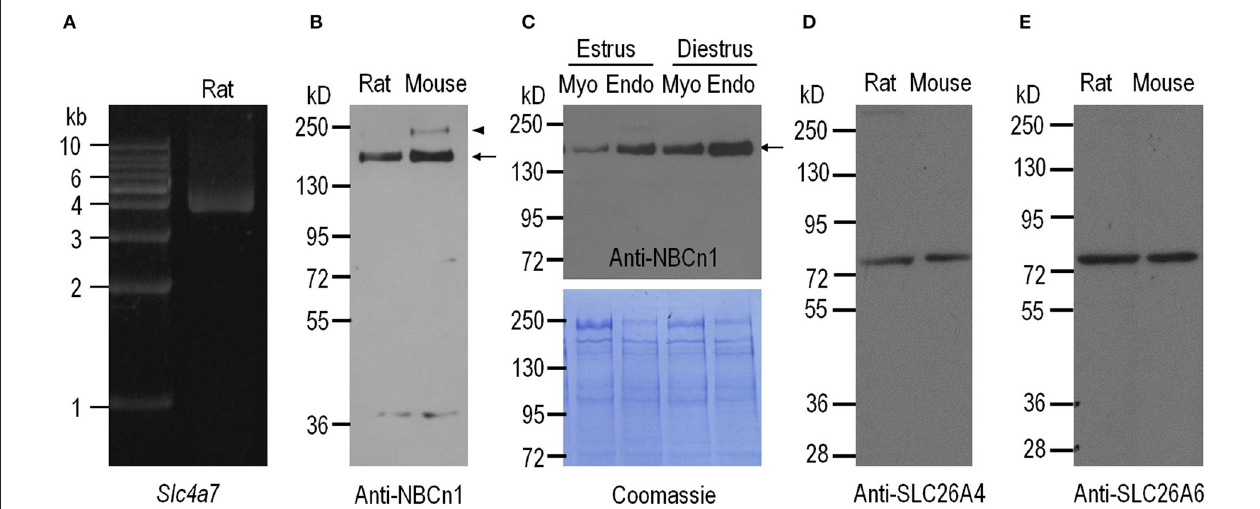
FIGURE 1 | Expression of NBCn1, SLC26A4, and SLC26A6 in uteri of adult rat and mouse. (A) RT-PCR analysis for expression of Slc4a7 encoding NBCn1 in the uterus of adult rat. (B) Western blotting analysis for expression of NBCn1 in the uteri of adult rat and mouse. (C) Western blotting analysis for expression of NBCn1 in endometrial layer (Endo) and myometrial layer (Myo) of rat uteri at estrus and diestrus (upper panel) and Coomassie Brilliant Blue staining of the blot (lower panel). (D,E) Western blotting analysis for expression of SLC26A4 and SLC26A6 in the uteri of adult rat and mouse. For quantitative comparison, 20 µ g of total membrane proteins were loaded for each lane in C . The arrows in B,C indicate the presumable glycosylated monomer of NBCn1, whereas the arrowhead in B indicates the presumable dimer of NBCn1. NBCn1 dimer was also observed in rat uterus upon a longer exposure (data not shown). Each panel is representative of three independent experiments.